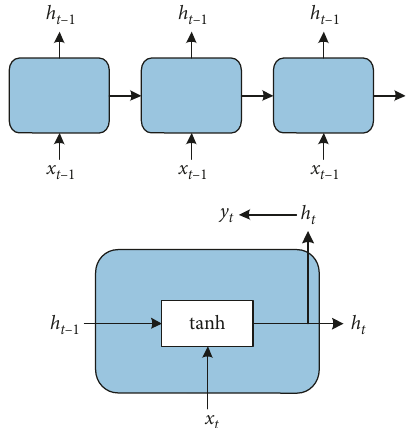
Figure 10: Structure of RNN and the memory